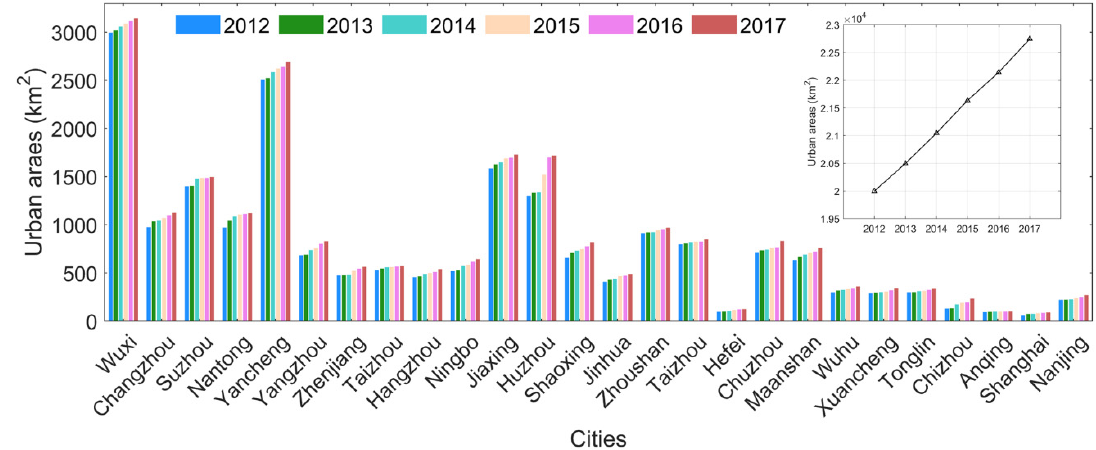
Figure 5. The increase in urban areas in all cities in the study area from 2012 to 2017.